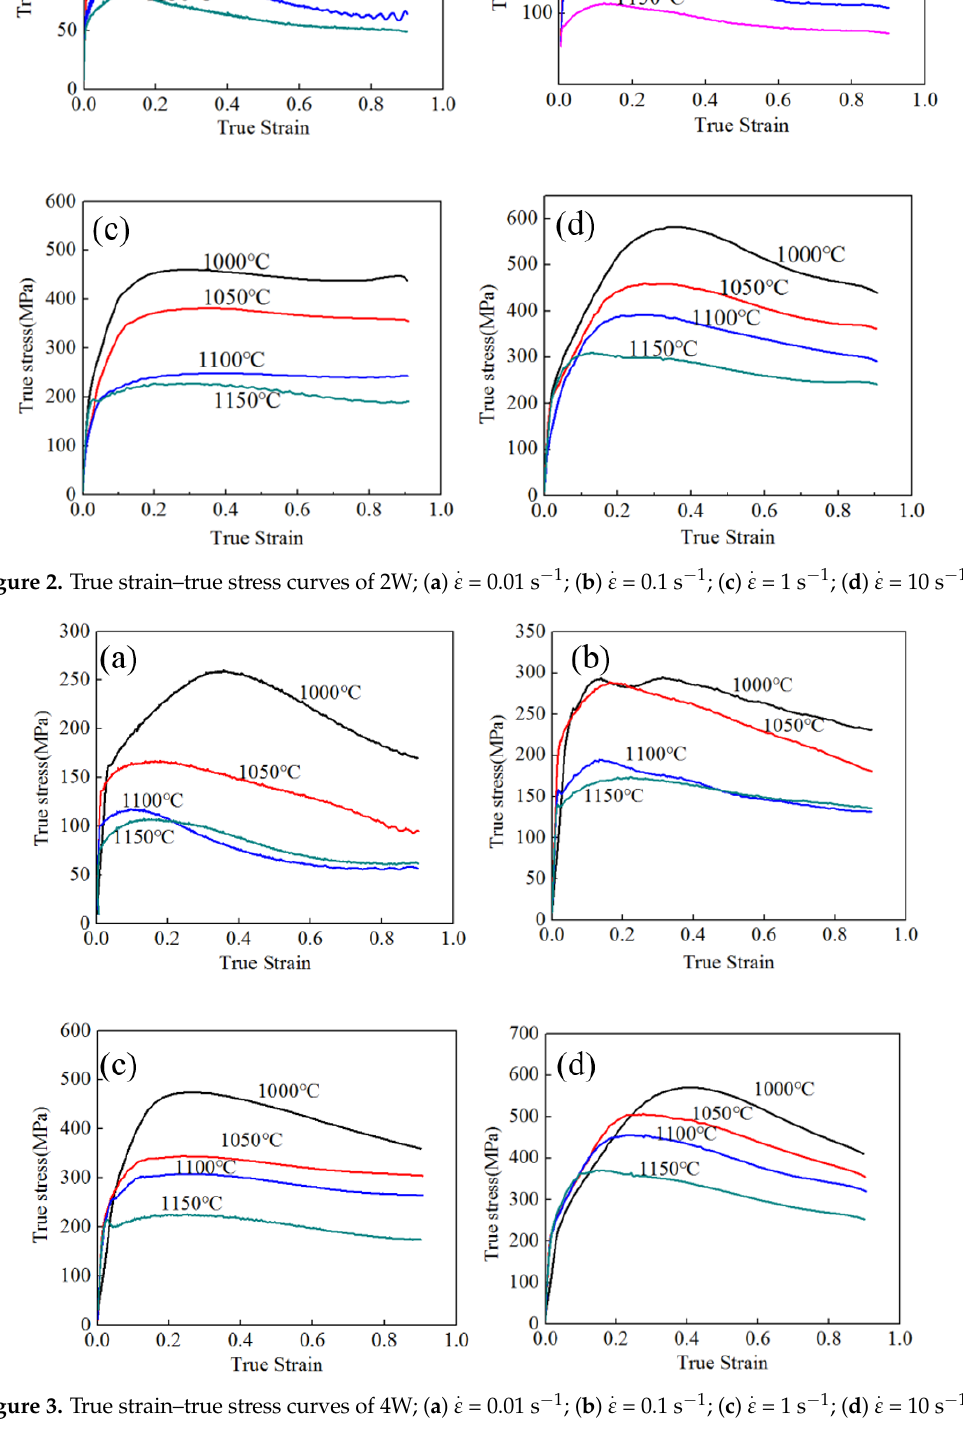
Figure 3. True strain–true stress curves of 4W; ( a ) 𝜀(cid:4662) = 0.01 s − 1 ; ( b ) 𝜀(cid:4662) = 0.1 s − 1 ; ( c ) 𝜀(cid:4662) = 1 s − 1 ; ( d ) 𝜀(cid:4662) = 10 s − 1 .